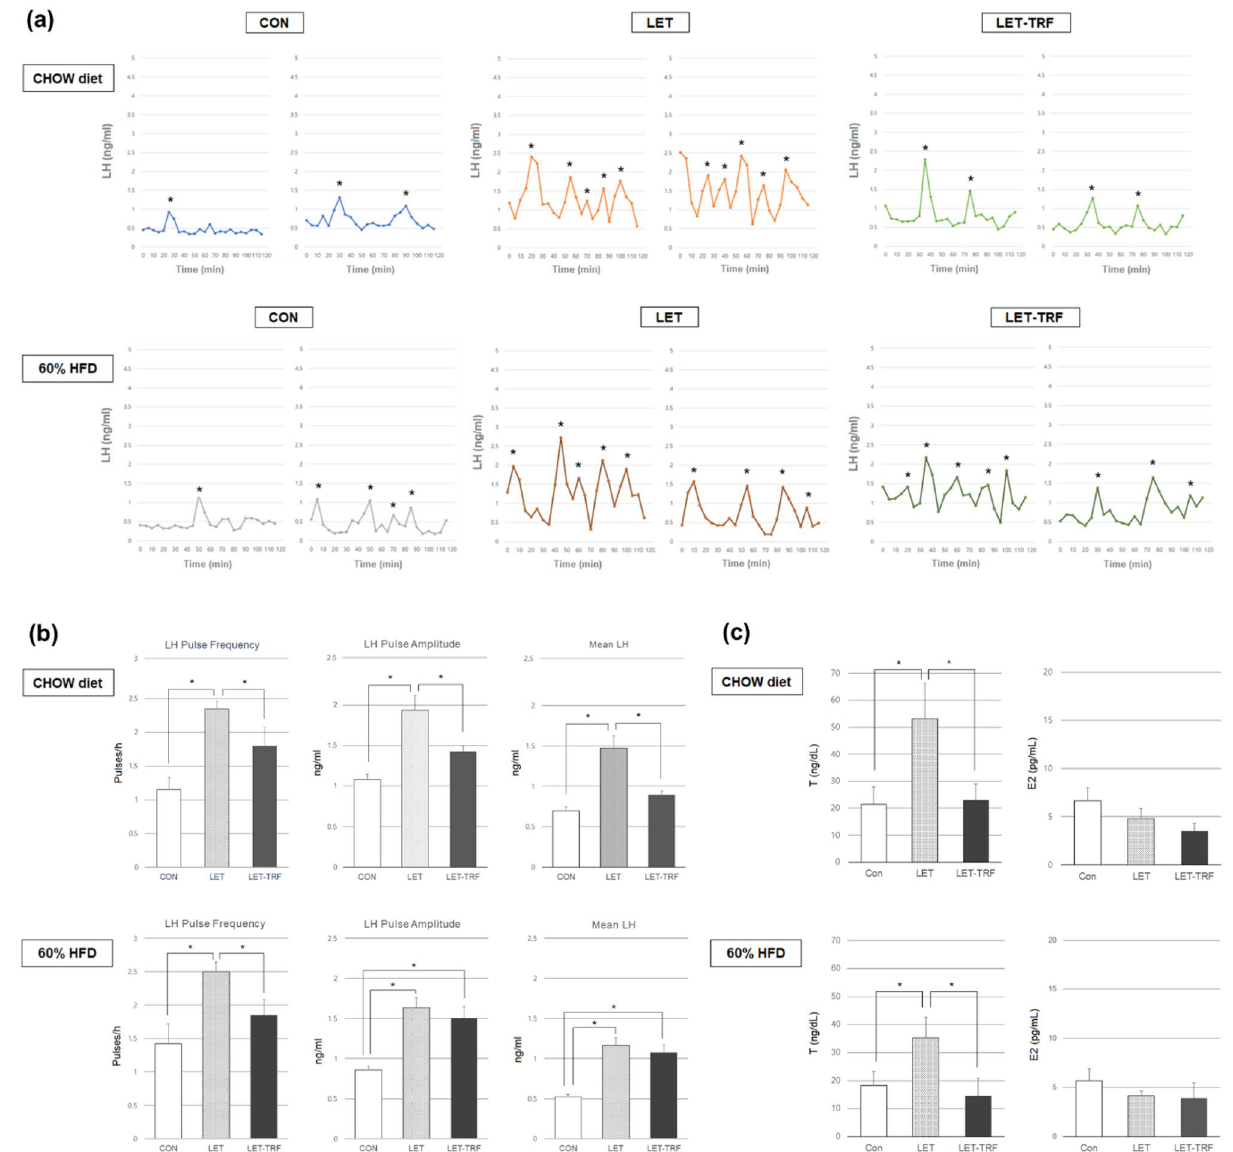
Figure 2. Endogenous pulsatile LH secretion profiles and serum sex hormone levels. ( a ) Representative LH pulse profiles from each of the two mice at diestrus in the CON, LET, and LET-TRF groups, which were fed either a CHOW diet or 60% HFD. Blood was collected every 5 min for a total duration of 2 h to generate LH pulse profiles at 10 weeks of age (6 weeks after letrozole or placebo pellet implantation). LET-TRF mice were fed the TRF regimen for 4 weeks, whereas the other mice were fed ad libitum. The asterisks indicate the identified pulse peaks. ( b ) Quantitative analyses of endogenous pulsatile LH secretion parameters. LH pulse parameters, including pulse frequency, pulse amplitude, and mean LH levels, were compared between the study groups ( * P < 0.05). ( c ) Comparison of mean serum levels of T and E2 between the study groups ( * P < 0.05). Serum was obtained at 10 weeks of age (6 weeks after letrozole or placebo pellet implantation). LET-TRF mice were fed the TRF regimen for 4 weeks, whereas the other mice were fed ad libitum. LH luteinizing hormone; 60% HFD, 60% kcal high-fat diet; TRF time-restricted feeding, T testosterone, E2